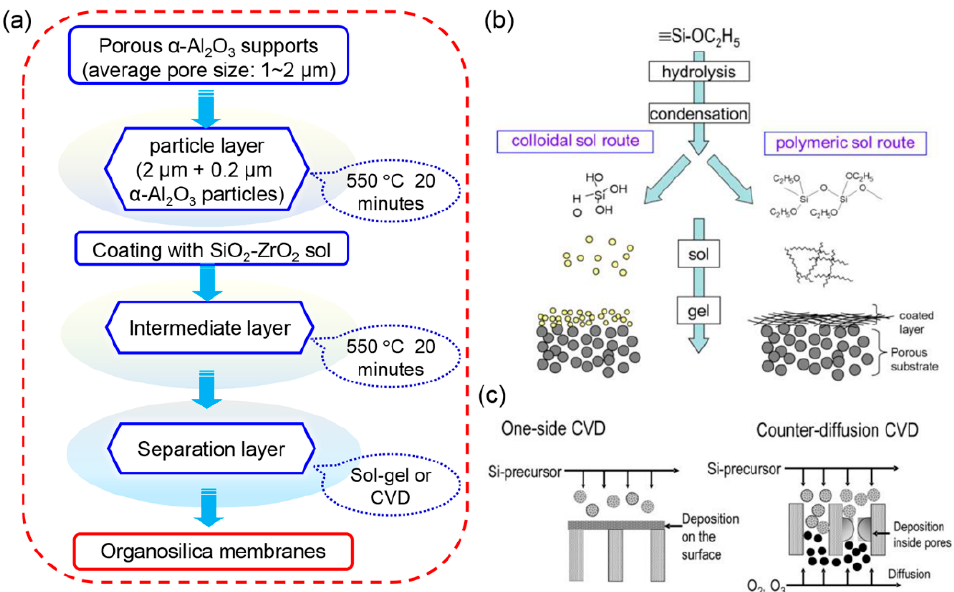
Figure 10. ( a ) Schematic illustration of the detailed fabrication process of organosilica